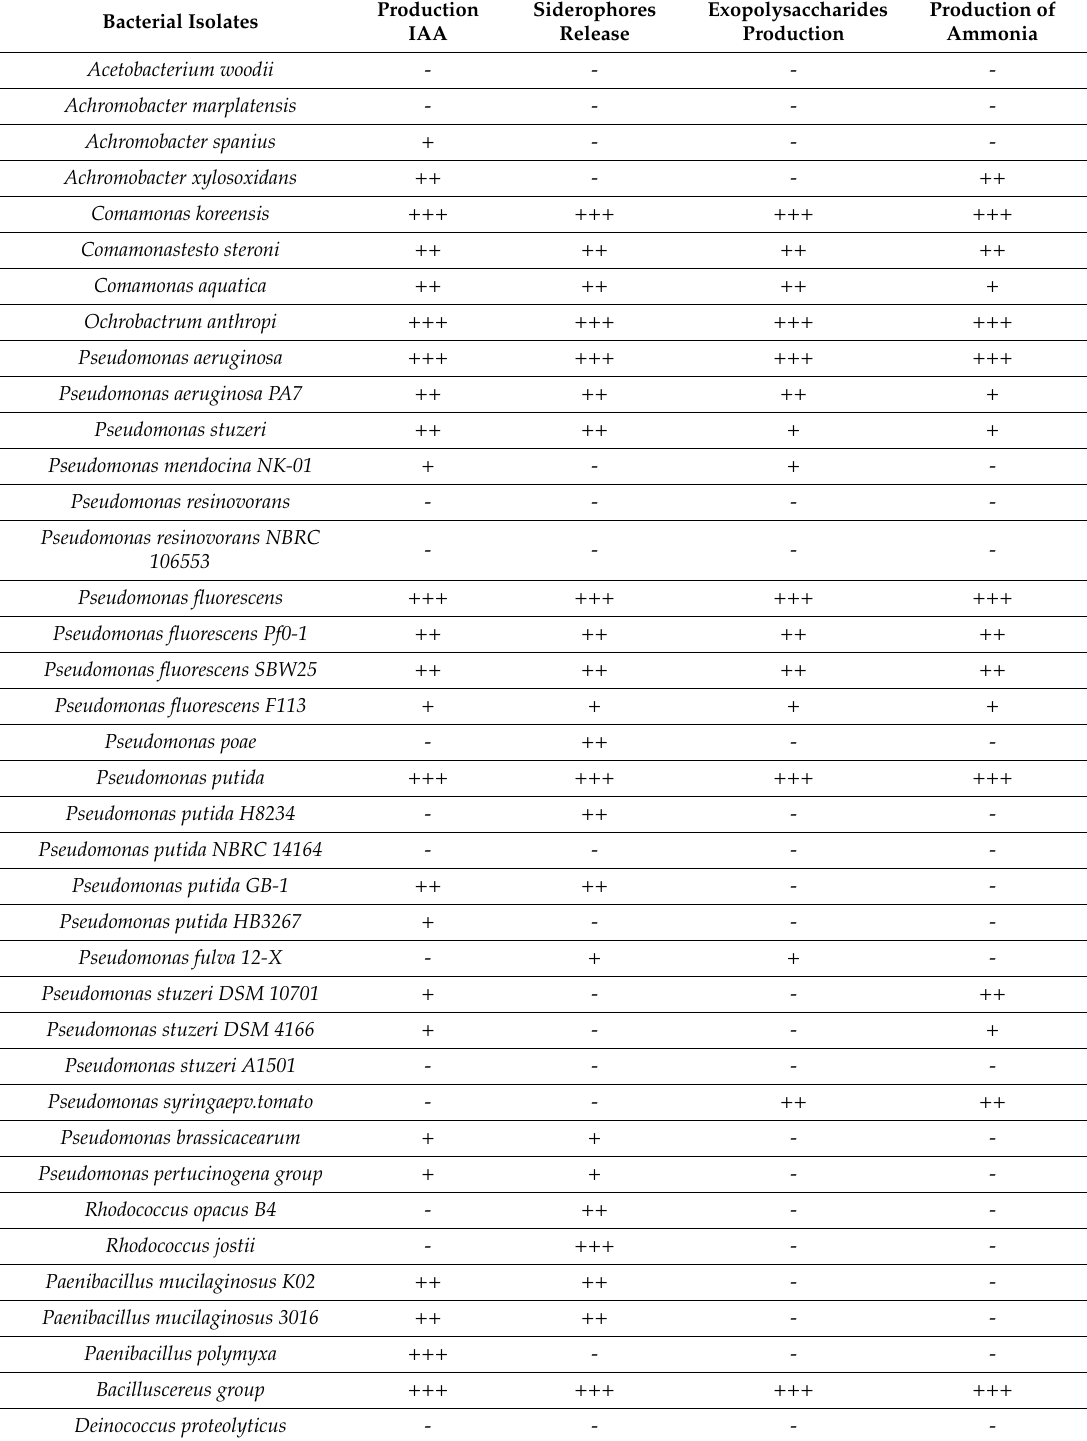
Table 1. Primary screening of the assessment of potential Plant growth-promoting rhizobacteria (PGPR) by bacteria isolates recovered from contaminated soil from a peri-urban cultivated area (Naples). The isolates were categorized into three groups according to the produced amount: + low concentrations ( < 1 µ g / mL), ++ moderate concentrations (1–2.99 µ g / mL), and +++ high concentrations ( > 3 µ g /